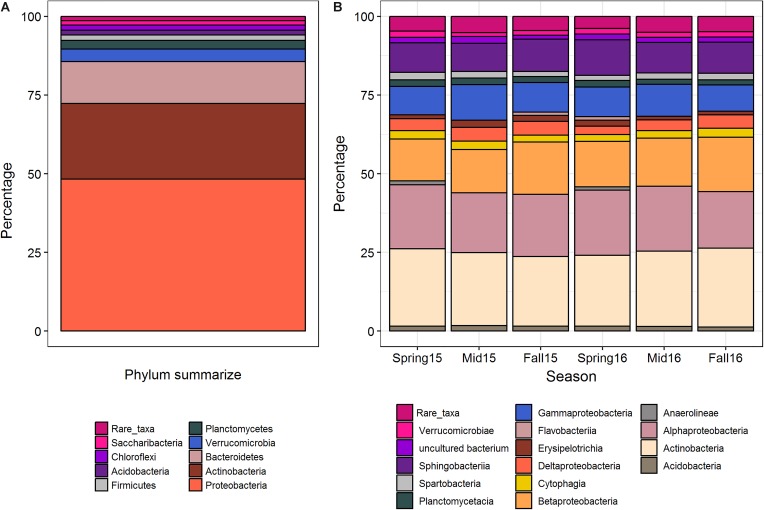
Summary of the average percentage of OTUs at the phylum level across all cyst samples (A), and average percentages at the class level across seasons (B). Rare taxa include those phyla or class that contributed less than 0.1% to the whole community.